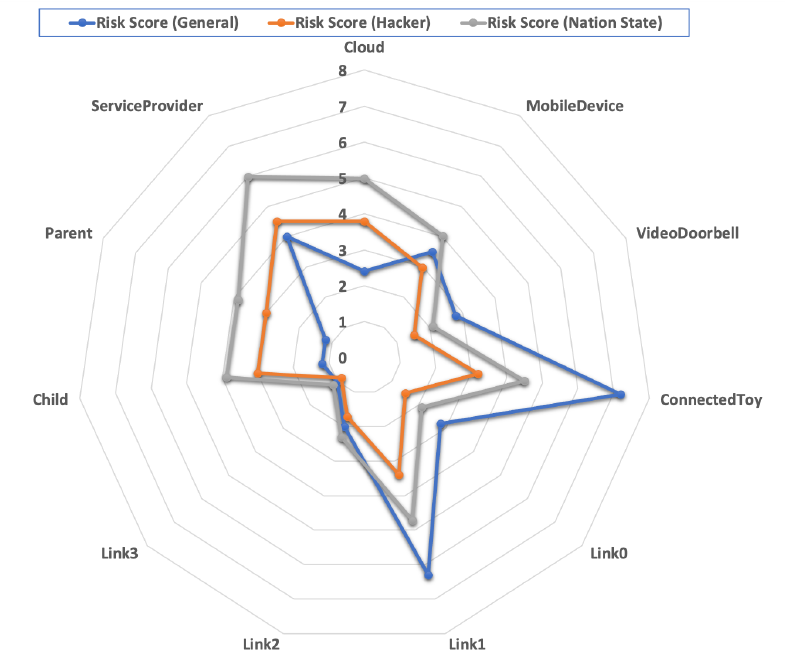
Figure 6. Radar chart indicating the risk level associated with each smart home component, including the risk score adjusted for the hacker and nation state actor. This figure shows that the highest risk (risk score > 7) is that of an attack targeting the ConnectedToy . Therefore, the most priority should be put on securing the ConnectedToy